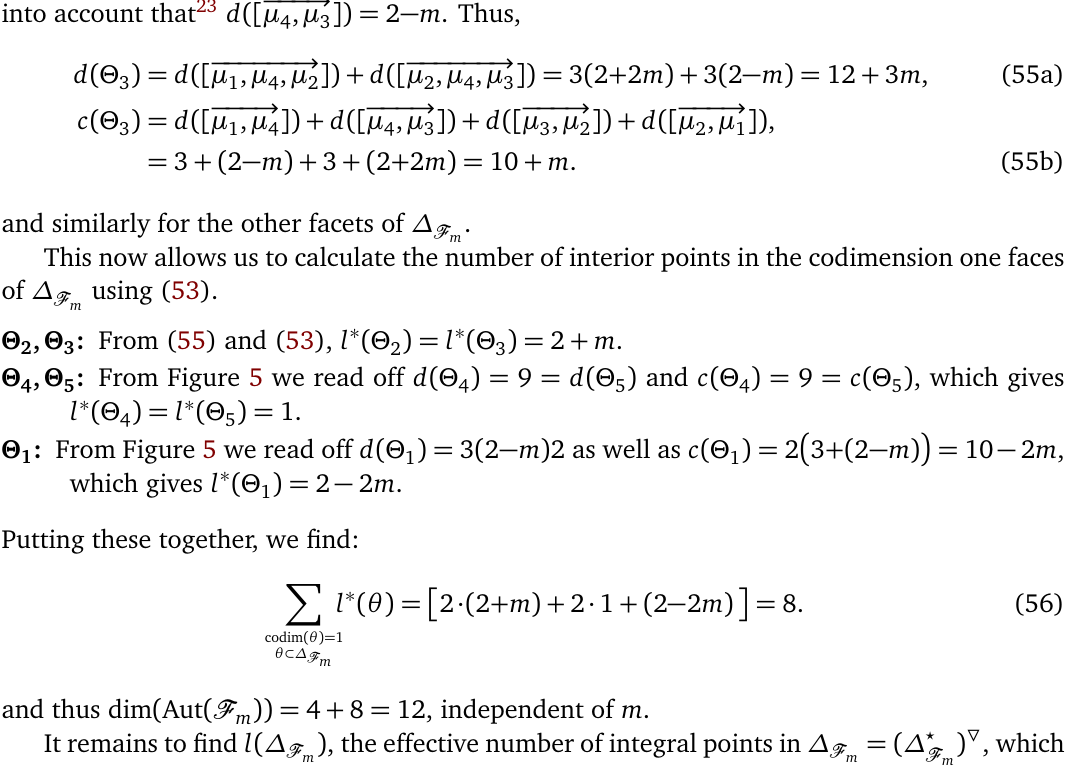
subdivided into a CCW- and a CW-oriented coarse simplex 3